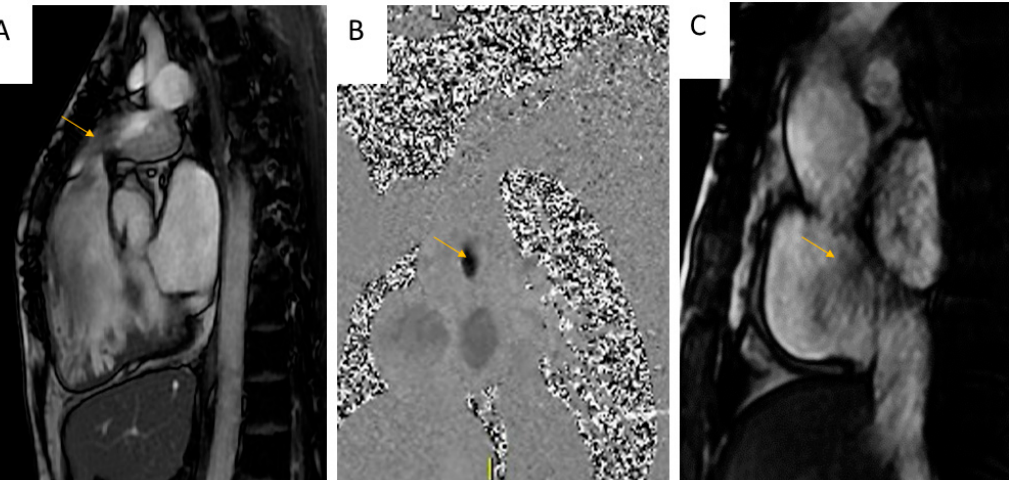
Figure 2. Assessment of Pulmonary Stenosis with Cardiac Magnetic Resonance: 2 ( A , B ) 40-year-old female patient with Pulmonary Stenosis. Visualization of a systolic “jet” (hypointense signal as a result of phase loss of proton spin due to turbulent flow) in pulmonary artery (arrow) with a cine-SSFP sequence. ( B ) Phase contrast sequence, visualization of hypointense signal at the level of luminal narrowing; 2 ( C ) 19-year-old male patient with pulmonary regurgitation, identification of diastolic “jet” in the right ventricle outflow tract.